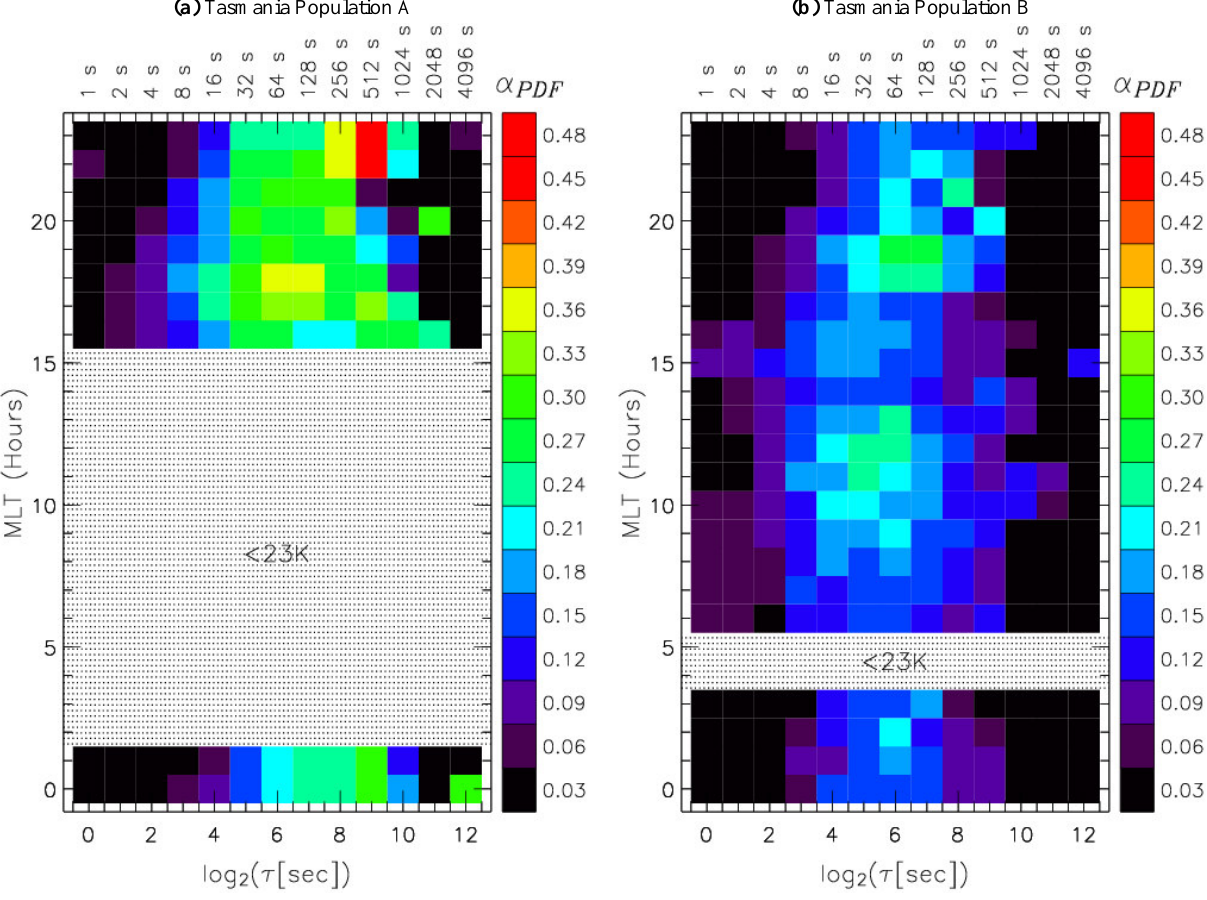
Fig. 12. (a) The variation of α PDF with τ and MLT for Tasmania Population A velocity fluctuations with spectral width < 75ms − 1 (see text). A bin size of 2h in MLT was used for the calculations. (b) The same except for Population B fluctuations with spectral width > 150ms − 1 . As in Fig. 9, scaling exponents were rejected when there were fewer than 23284 samples at τ =1s (dotted